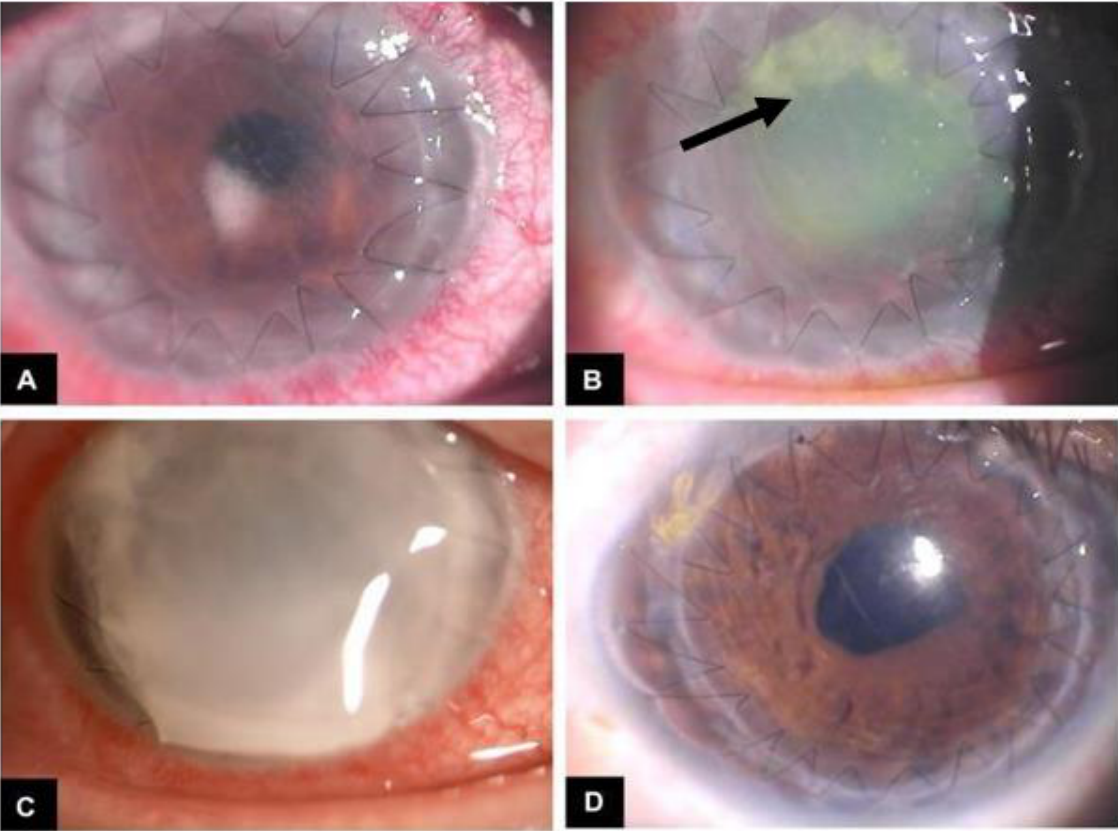
Figure 3. A biomicroscopic image of the disease progression and treatment of an Aspergillus infection after penetrating keratoplasty (PKP). ( A ) Eye 4 days after PKP. ( B ) After 6 days, the progression of the disease is quite apparent with white infiltrates and stromal melting (arrow). ( C ) Nine days after initial infection, with the anterior chamber being affected completely. ( D ) Three months later, showing clearance of the disease with restoration in the clarity of the anterior chamber and corneal graft. Image courtesy: Spadea et al. [18] .